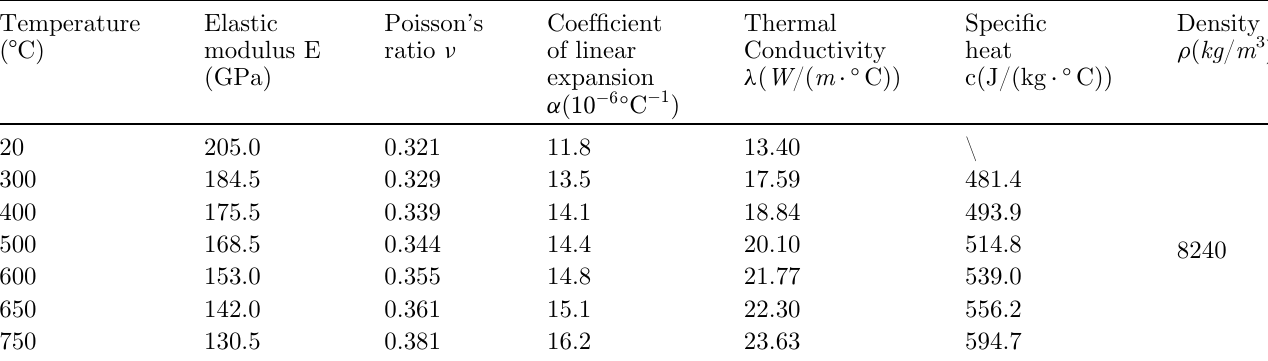
Table 1. Temperature dependence of thermodynamic parameters of GH4169 superalloy [14]. Temperature